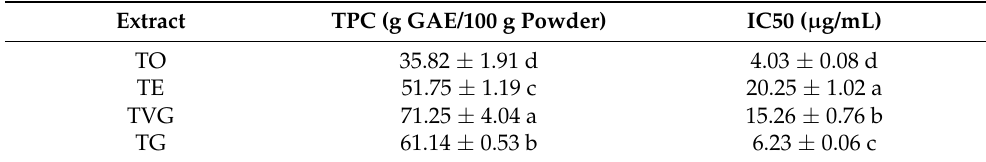
Mean ± SD ( n = 6). Means with different letters in columns are significantly different ( p <